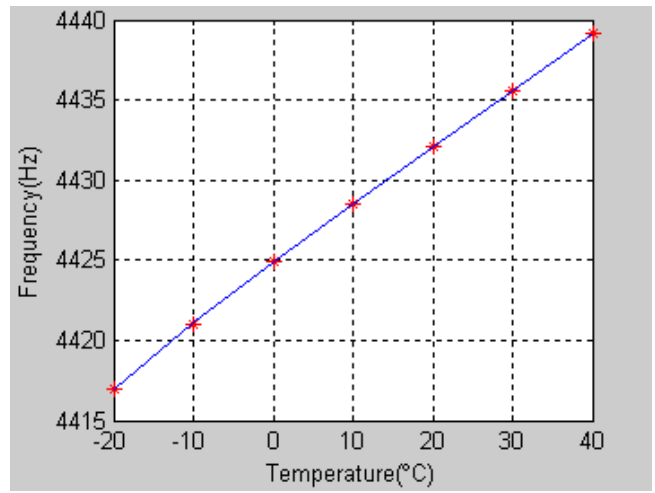
Figure 4. Temperature-frequency fitting curve.